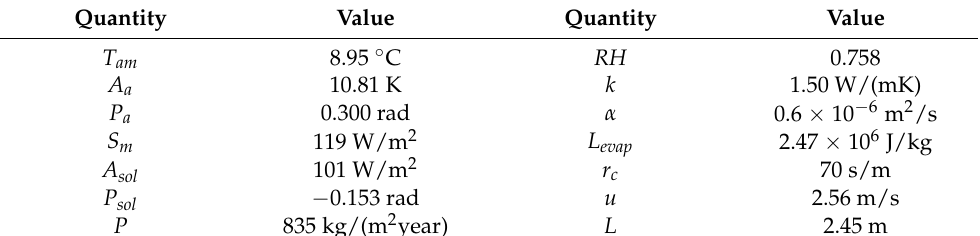
Table 1. Numerical values used for calculating the temperature field under natural conditions.